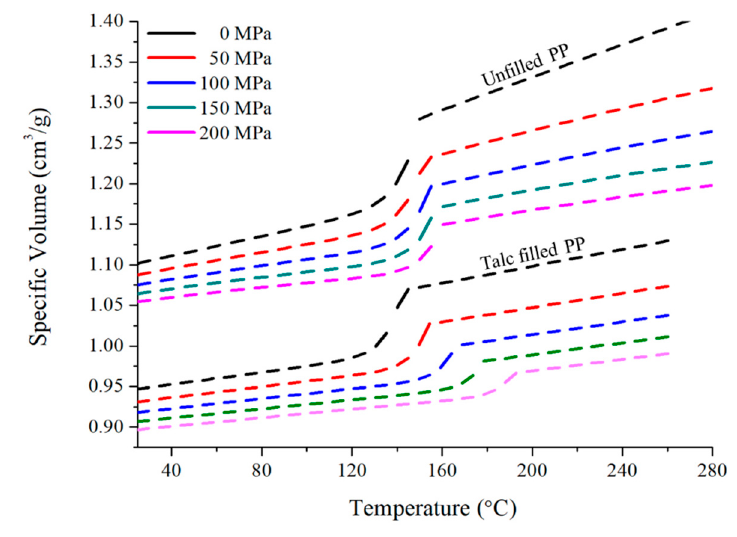
Figure 1. Pressure-Volume-Temperature data for unfilled PP and talc-filled PP.